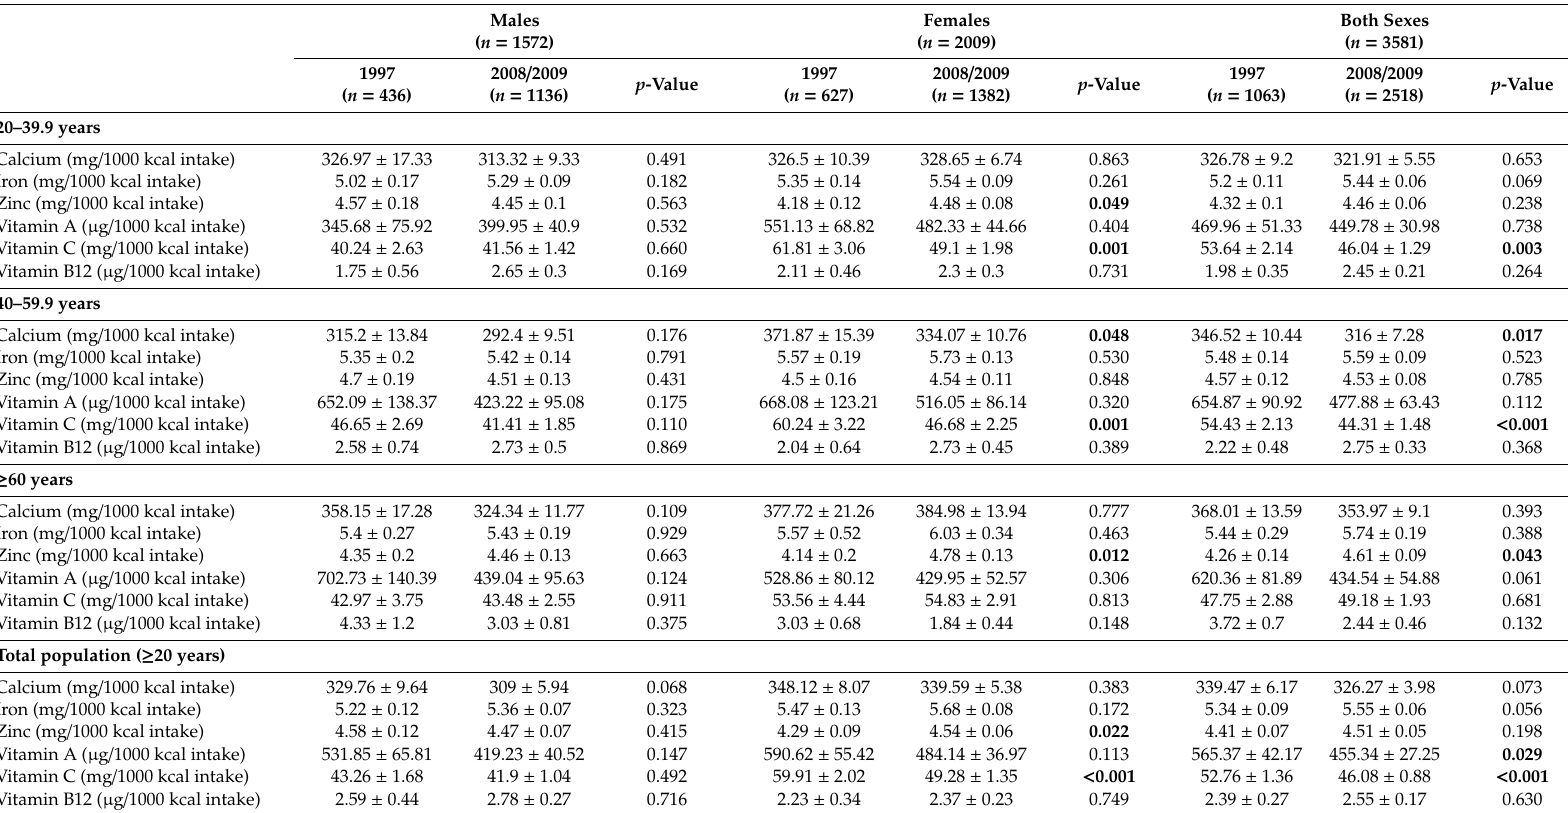
Table 4. Mean daily micronutrient density (by sex and age) and their comparison between 1997 and 2008 / 2009, in the study population ( n = 3581), aged ≥ 20 years,